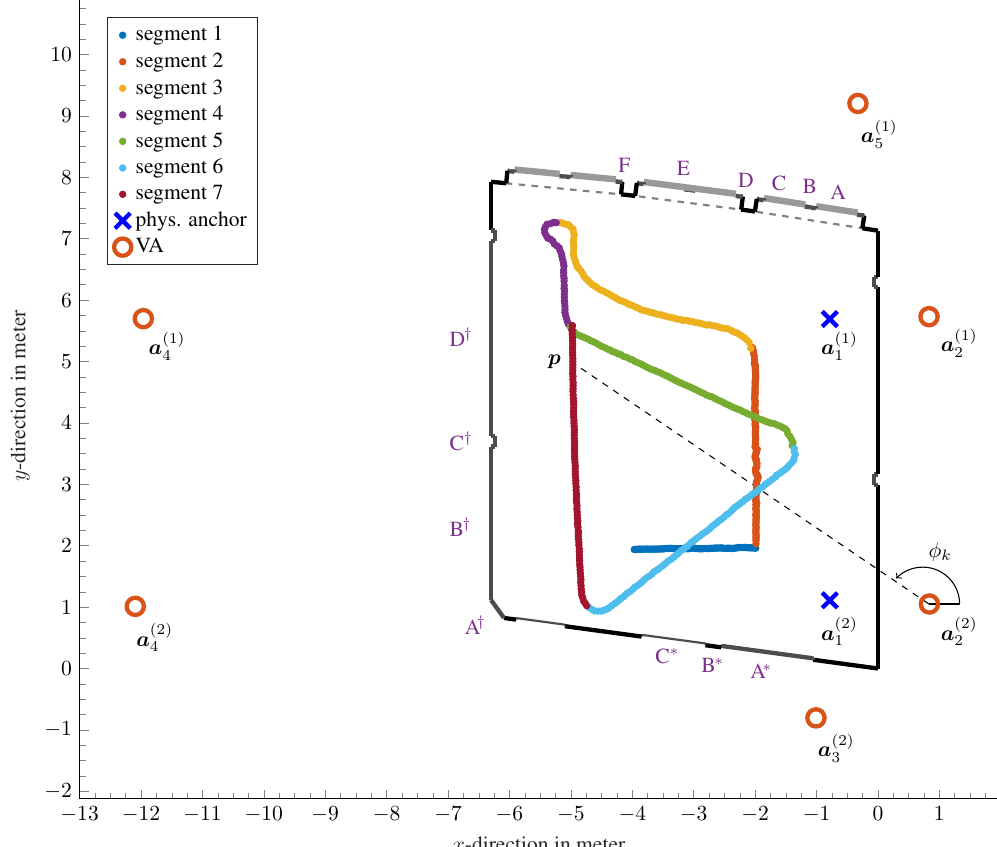
Figure 1. Floor plan of the evaluation scenario. Bold black lines denote walls, thick gray lines represent glass windows, other lines illustrate other materials. Two blue crosses represent the physical anchors; orange circles denote virtual anchors (VAs) which were considered in the experimental validation. An agent moves along a trajectory segmented into seven parts indicated with distinct colors. Capital letters (with or without mark or †) refer to sub-segments of different materials along ∗ each